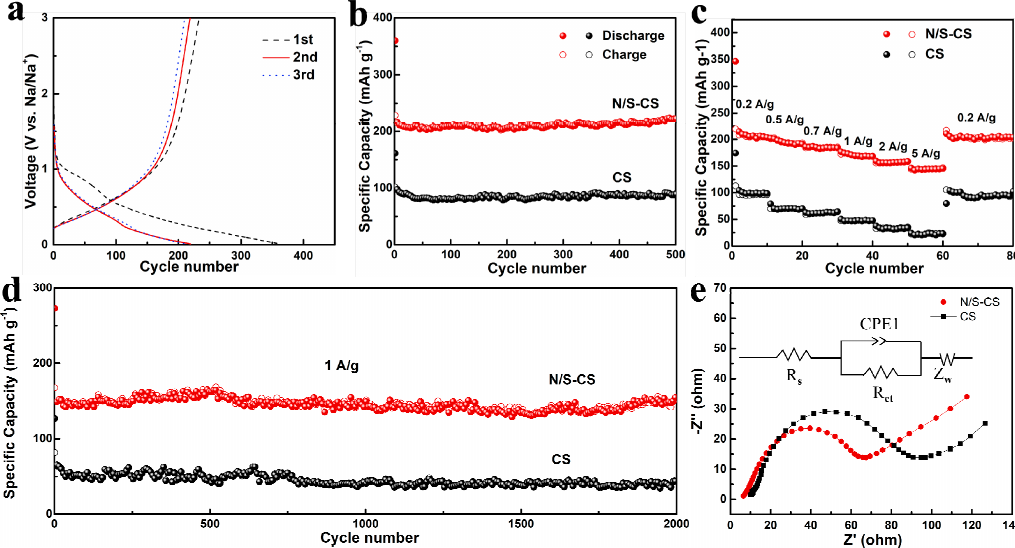
Figure 4. ( a ) Discharge / charge profiles of N / S-CS; ( b ) cycling performances at 0.2 A g − 1 ; ( c ) rate performances; and ( d ) long-term cycling performances at 1 A g − 1 of N / S-CS and CS; ( e ) Nyquist plots of N / S-CS and CS after 200 cycles .